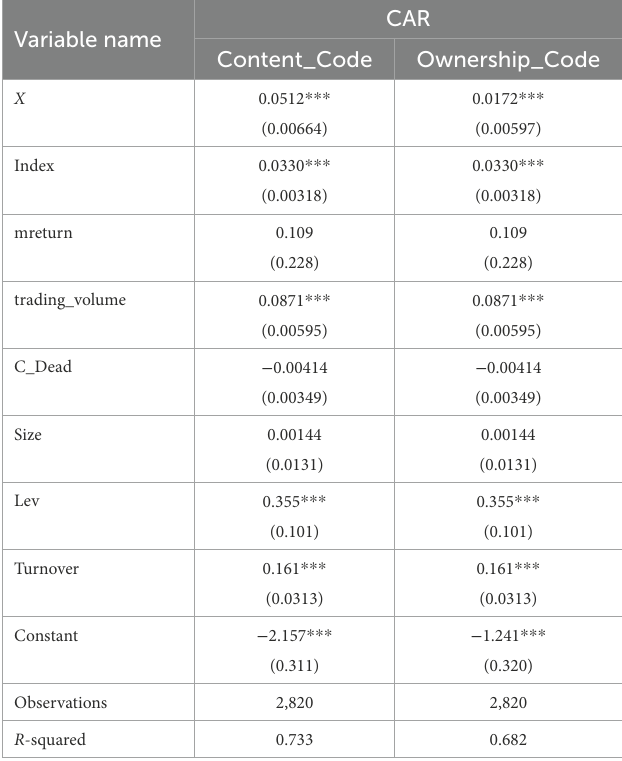
TABLE 3 Regression results of donation content and nature of business on CAR.